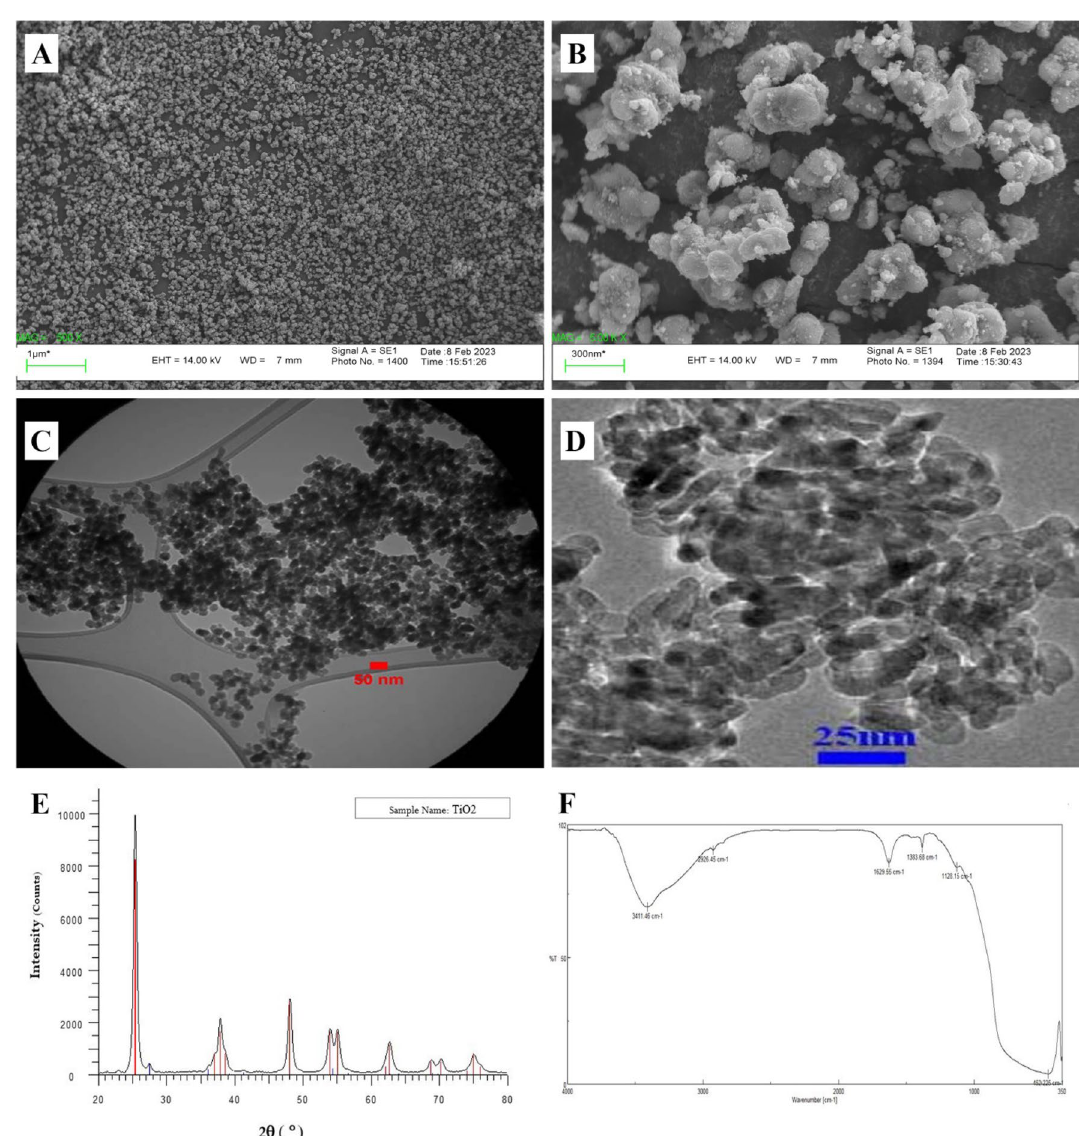
Figure 1. Representative scanning electron microscope (SEM), transmission electron microscopy (TEM) images ( A – D ), X-ray diffraction (XRD) pattern ( E ), and fourier-transform infrared spectroscopy ( F ) of titanium dioxide (TiO 2 ) nanoparticles employed in the present